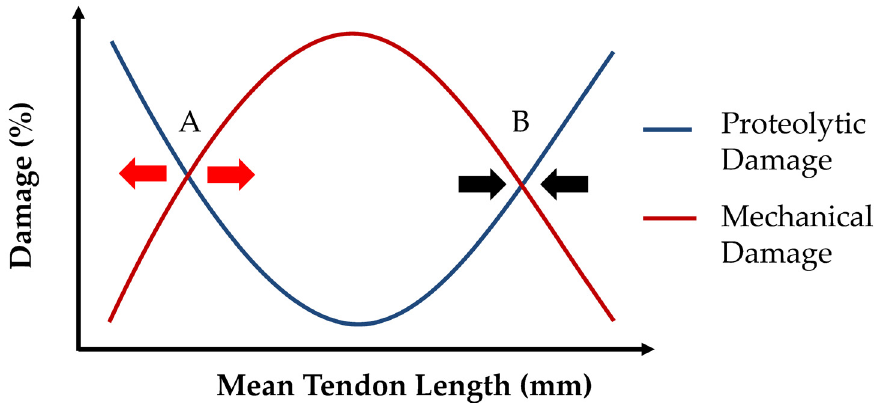
Fig 13. Relative relation of mechanical and proteolytic damages at different mean tendon lengths. Intersection at point A denotes an unstable state where remodeling lengths diverge. Point B denotes a stable state where remodeling lengths converge. Arrows signify the direction of tendon length change driven by damage and repair